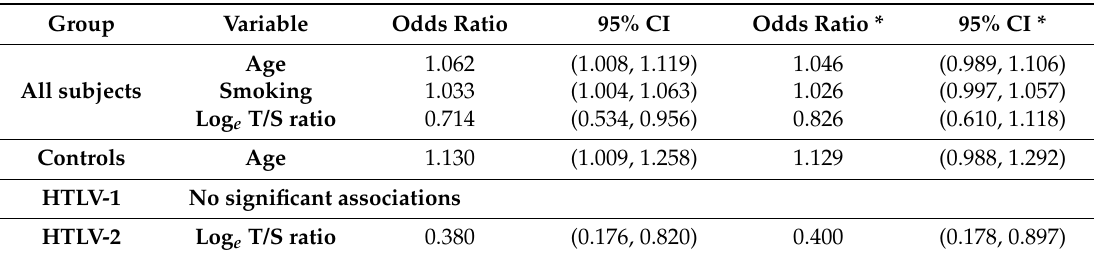
Table 3. Variables associated with tuning fork sensation